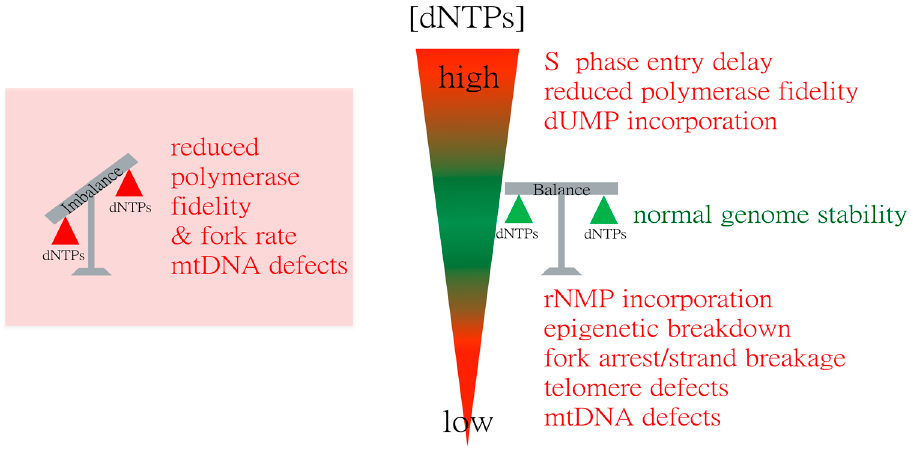
Figure 2. Summary of consequences of abnormal dNTP levels.